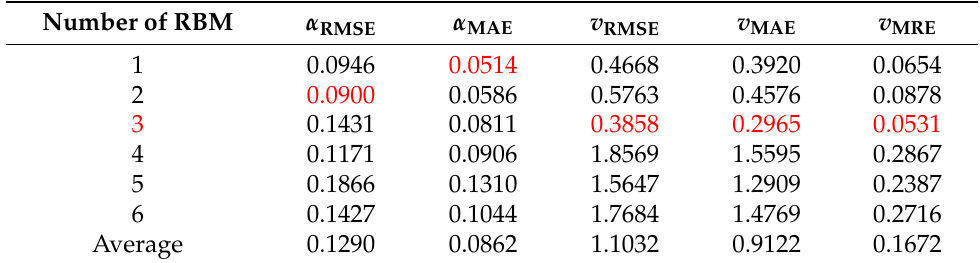
Table 5. Prediction results of different hidden layers for front wheel angle and